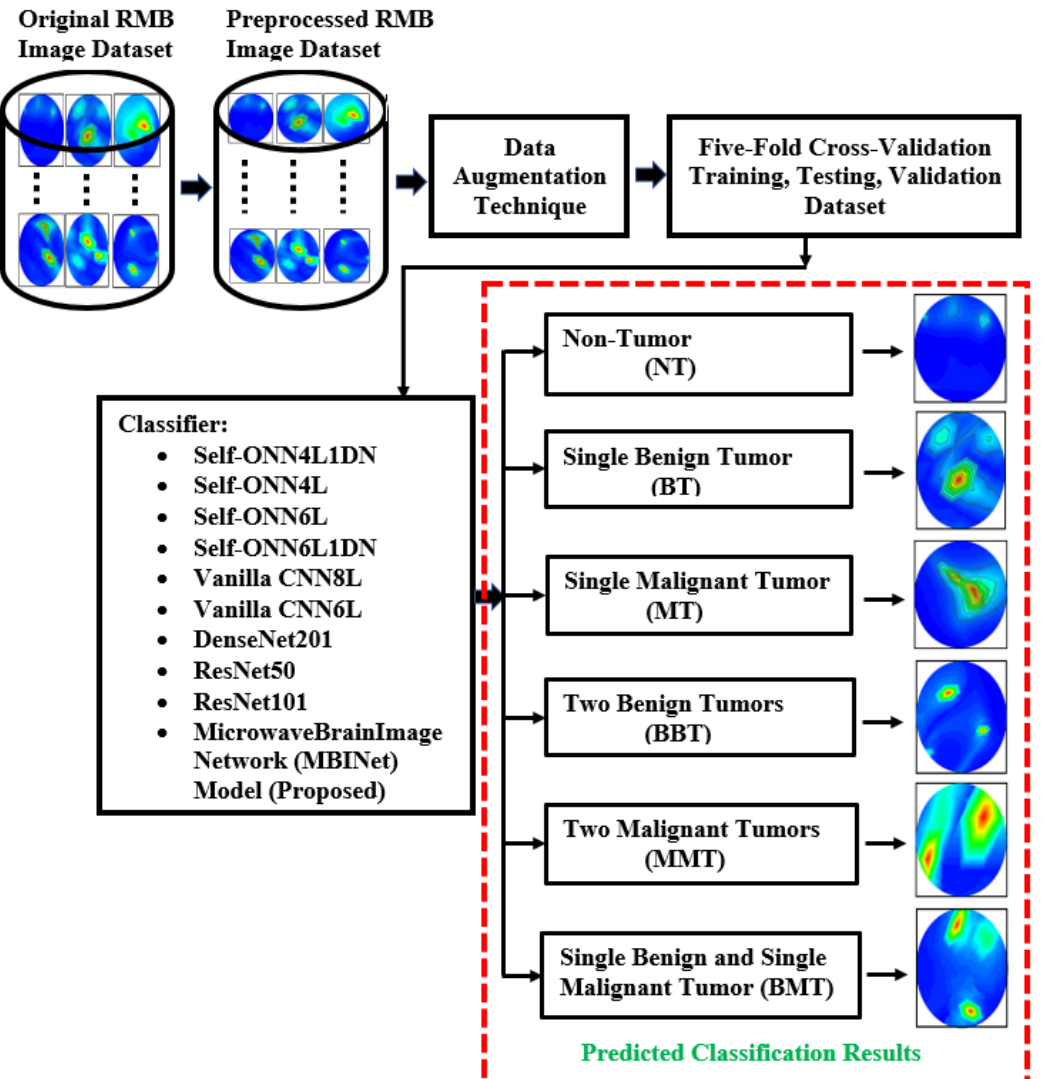
Figure 4. The flowchart for the complete research process.